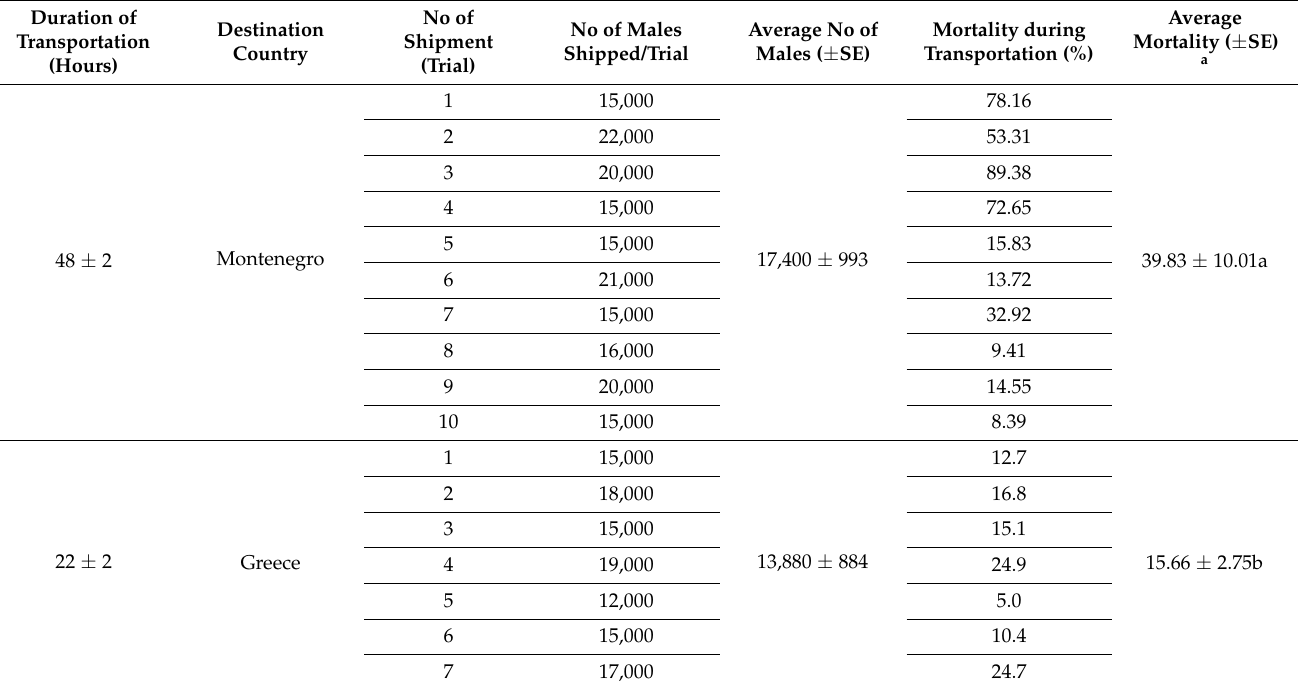
Table 2. The effect of duration of transportation on irradiated male mosquito mortality (around 1500 sterilized males/box).